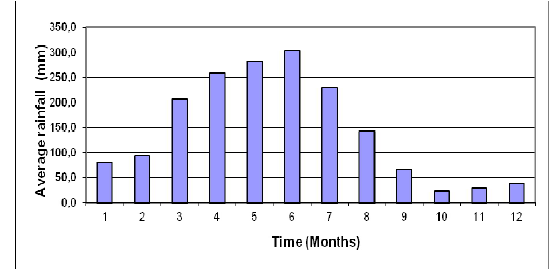
Figure 2. Monthly rainfall distribution